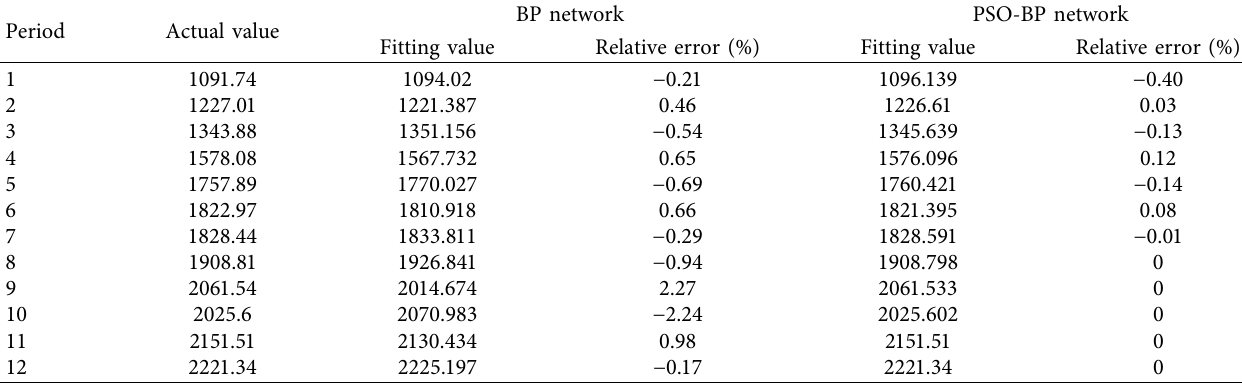
Table 6: ZL2-7 actual value and model fitting value.